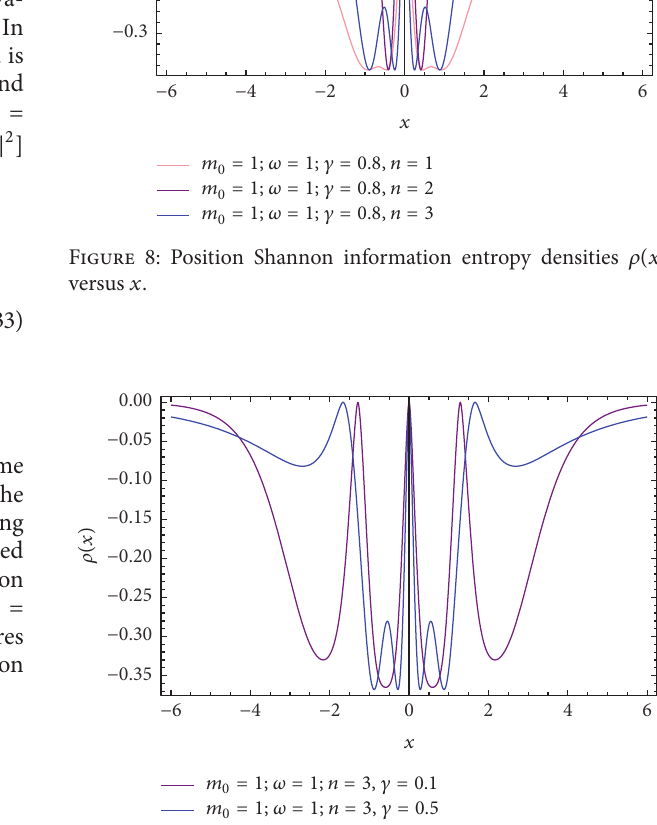
Figure 9: Position Shannon information entropy density 𝜌(𝑥) versus 𝑥